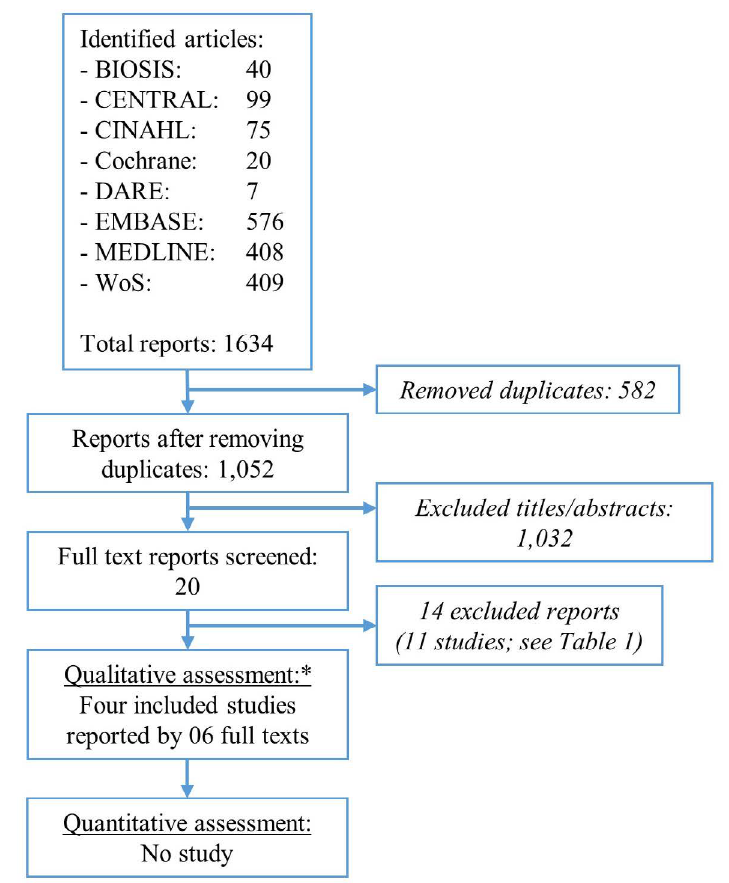
Figure 1- Flow diagram of study selection. No study was located from other sources, including the references of screened full text reports and reviews. *Qualitative appraisal of the body of studies (without quantitative